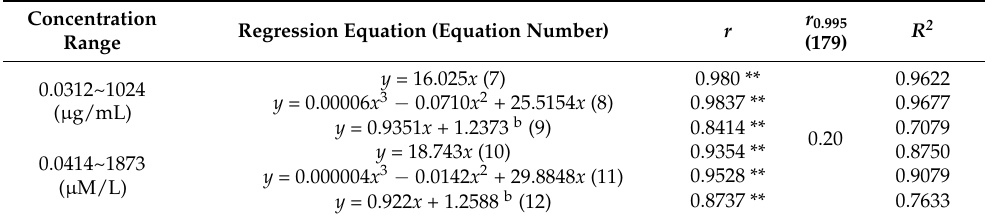
Table 5. Regression equations between the MIC ( x ) and the corresponding MPC ( y ), of antimicrobial agents against pathogenic bacteria ( n = 181) a .